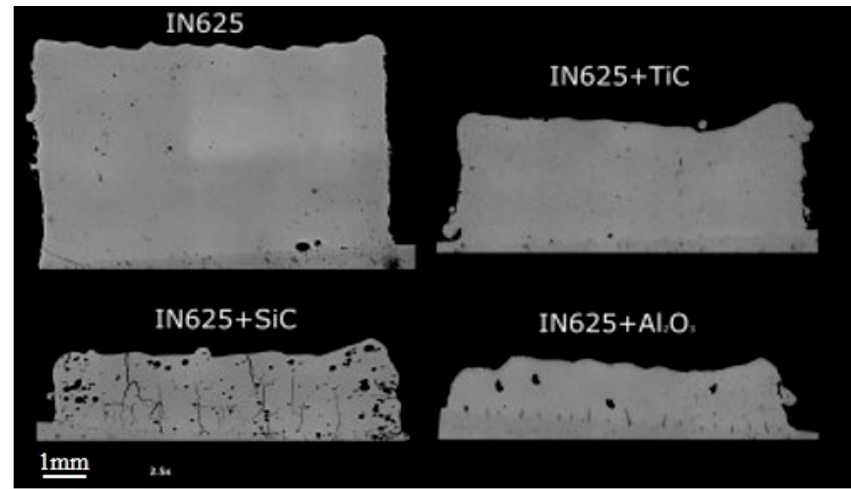
Figure 1. OM image of cross-sections of different composites [58].